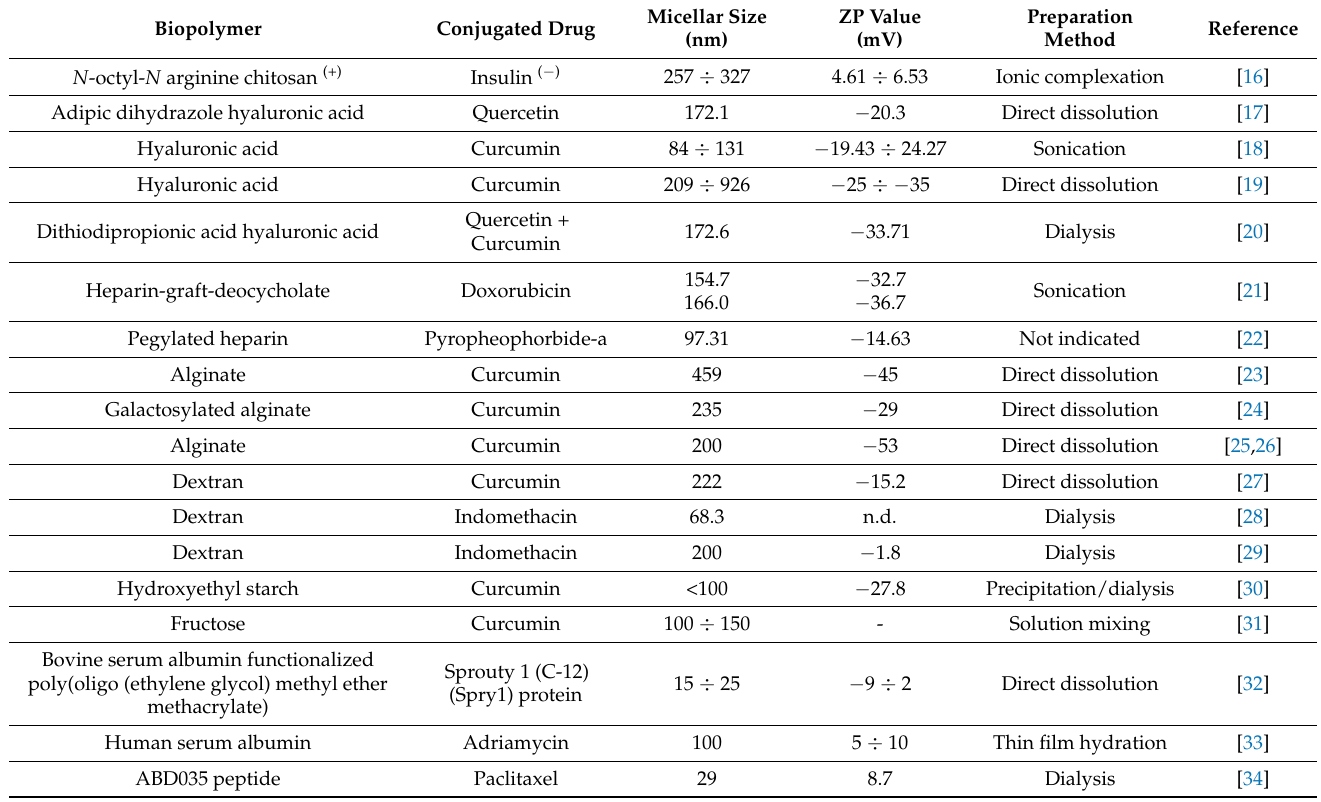
Table 1. Micellar DDS based on drug/biopolymer